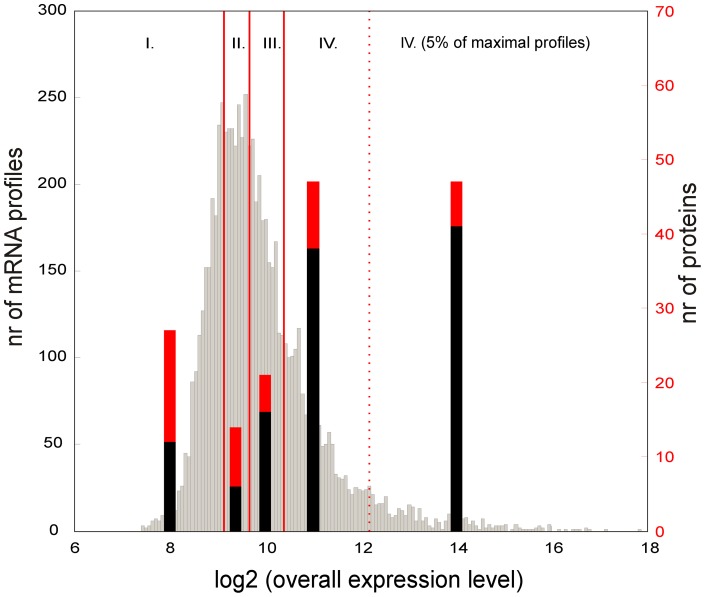
Distribution of the medians of the gene expression profiles, given in absolute units, as measured in the microarray alpha channel.The distribution is divided into 4 quartiles (roman numbers) and the last 5% of the most highly expressed genes. Vertical bars represent the number of proteins of Sypro Ruby-stained (red bars) or radiolabeled (black bars), in the proteome that corresponds to the genes in the given quartile.